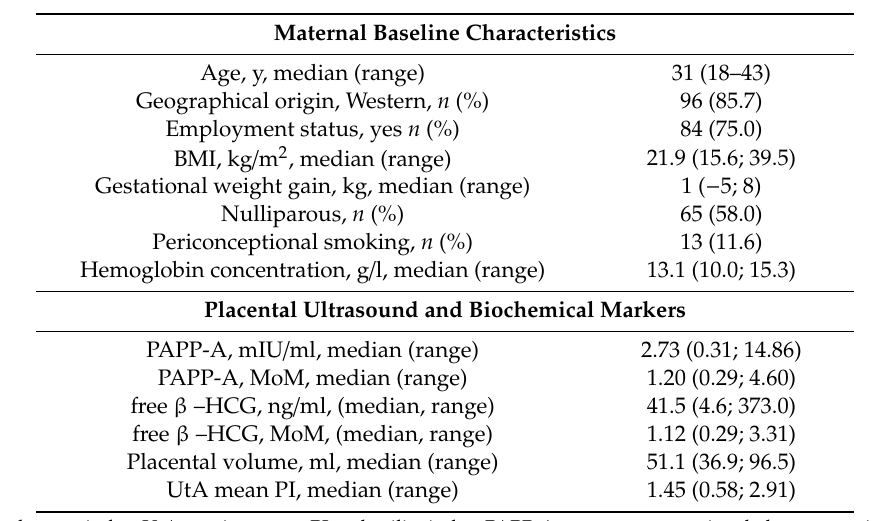
Table 2. Maternal baseline characteristics and first trimester placental markers of the study population ( n = 112).